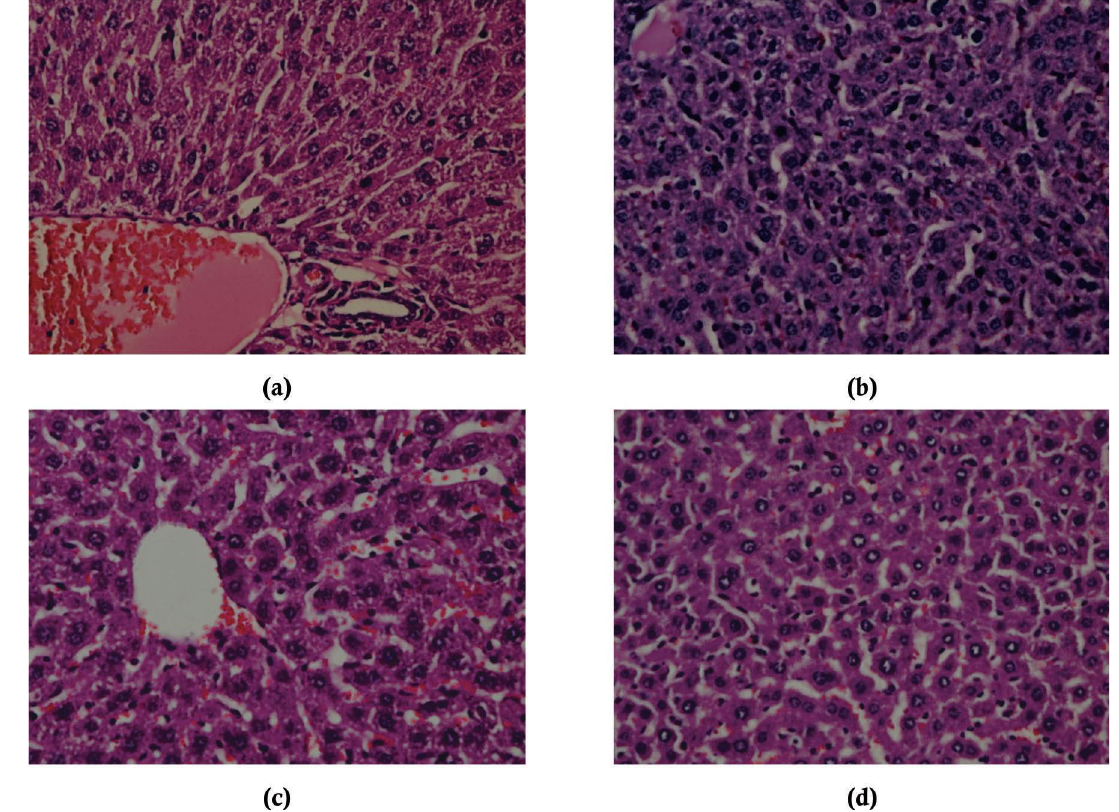
Figure 2. Livers’s microscopic view of each group (a) Group C (Control), (b) Group T1 (dose 2000 mg/KgBW), (c)